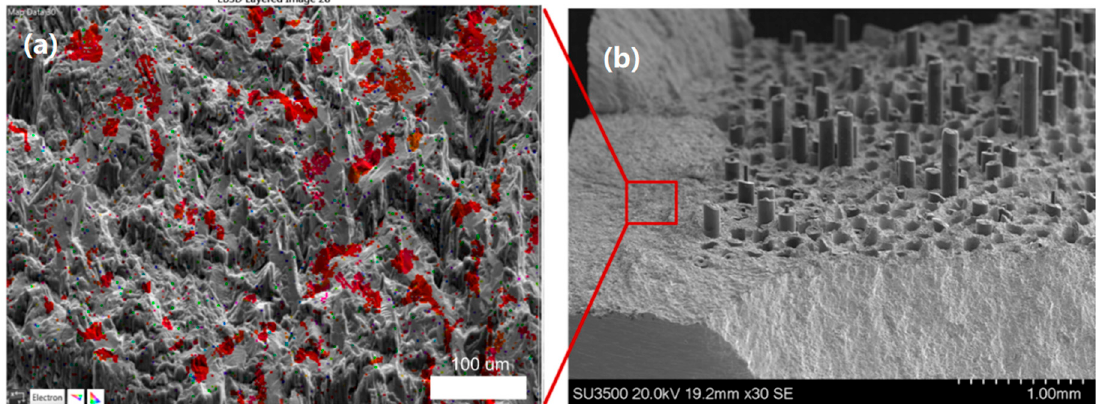
Figure 12. High density of basal facets discovered in IP 1000 MPa cladding area, which gave rise to crack initiation and premature failure. ( a ) IPF Z EBSD map of fracture surface imposed over tilt compensated SEM image; ( b ) low magnification SEM image of tilted stage before EBSD analysis.